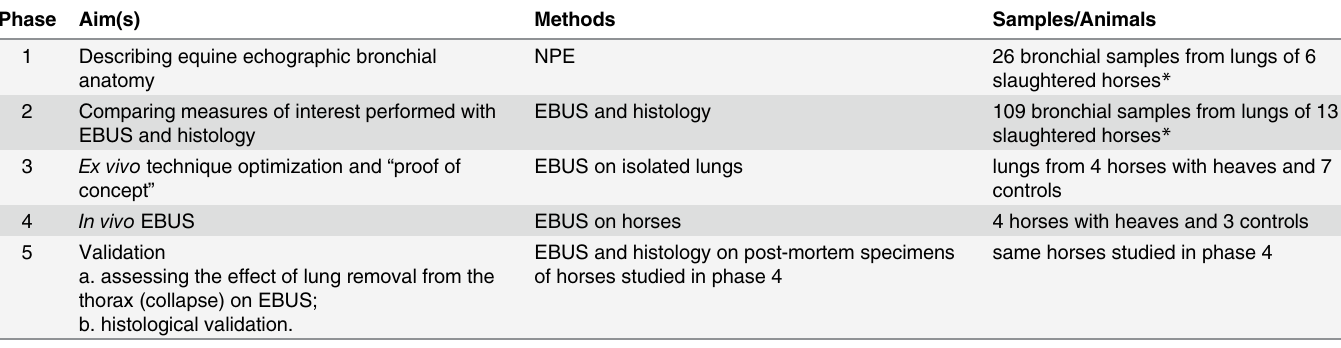
Table 1. Study design.